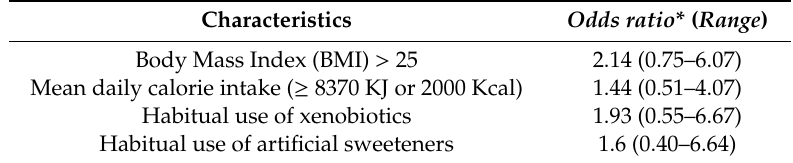
Table 1. Correlation analysis between anthropometric and nutritional characteristics and habitual intake of xenobiotics by the participants and number of detected antimicrobial resistance genetic markers (ARG).